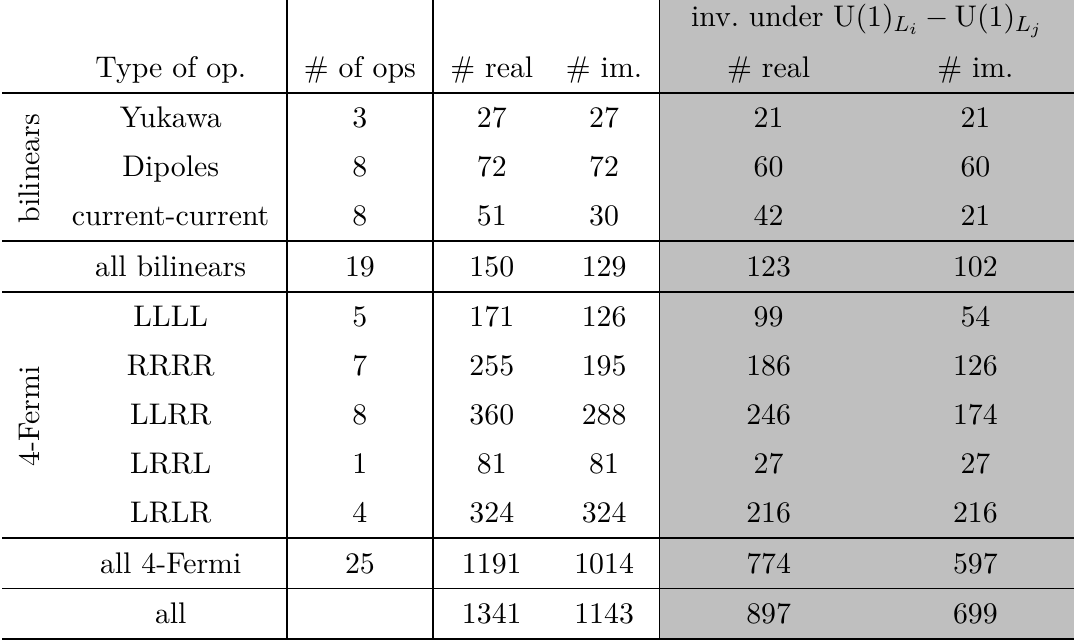
Table 2 . Number of flavorful real and imaginary parameters in SMEFT at dimension-six (see tables 7 and 8 for the explicit forms of the operators). The first double column counts the number of physical parameters, the second one (highlighted in gray) counts those which are also primary (see the